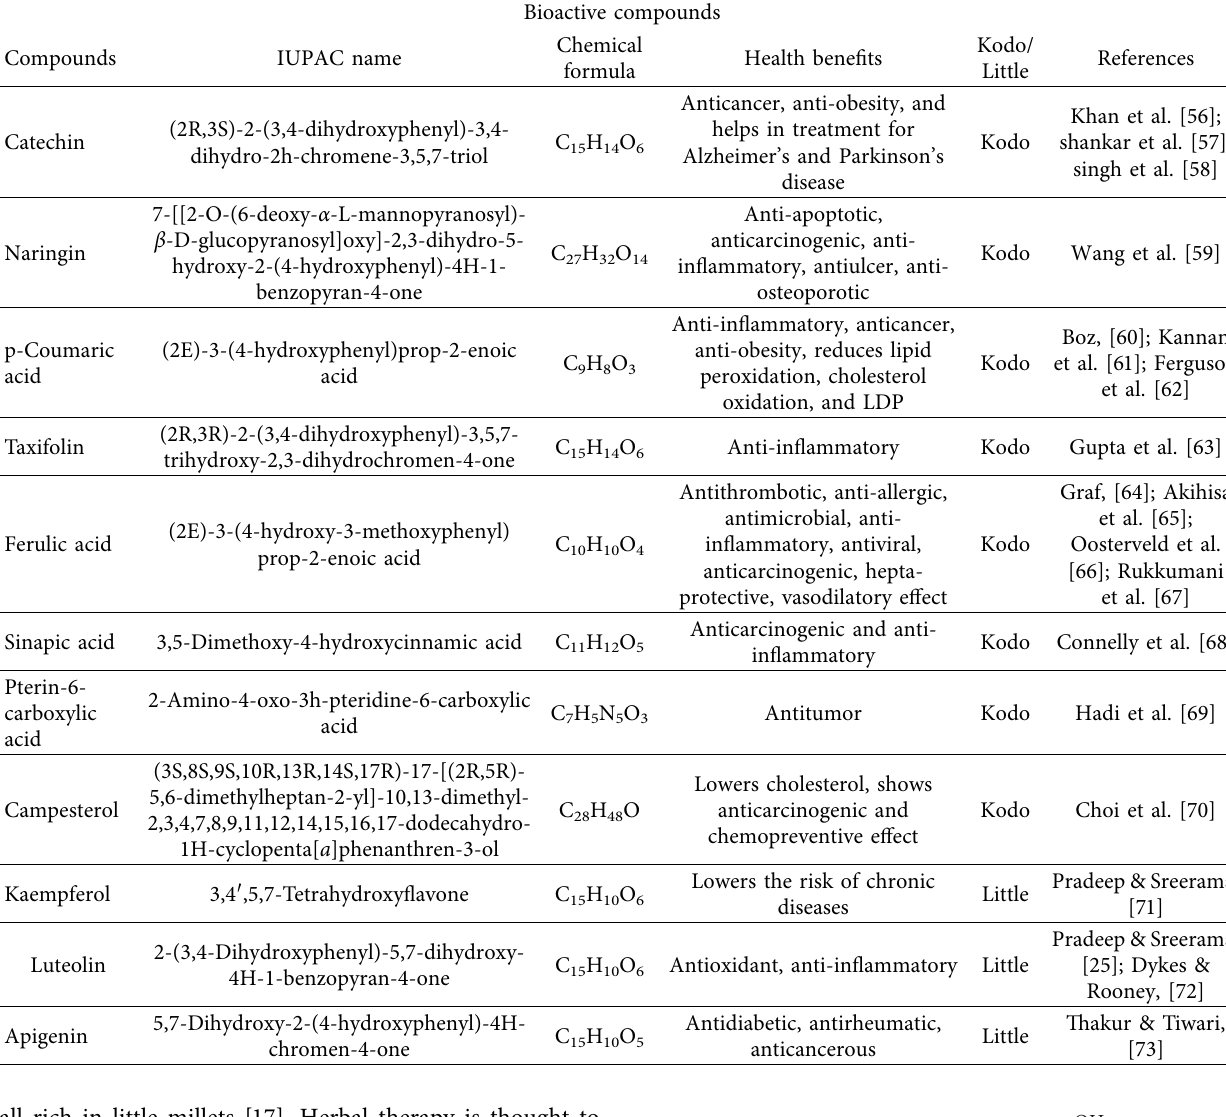
Table 5: Bioactive compounds found in kodo/little millets.